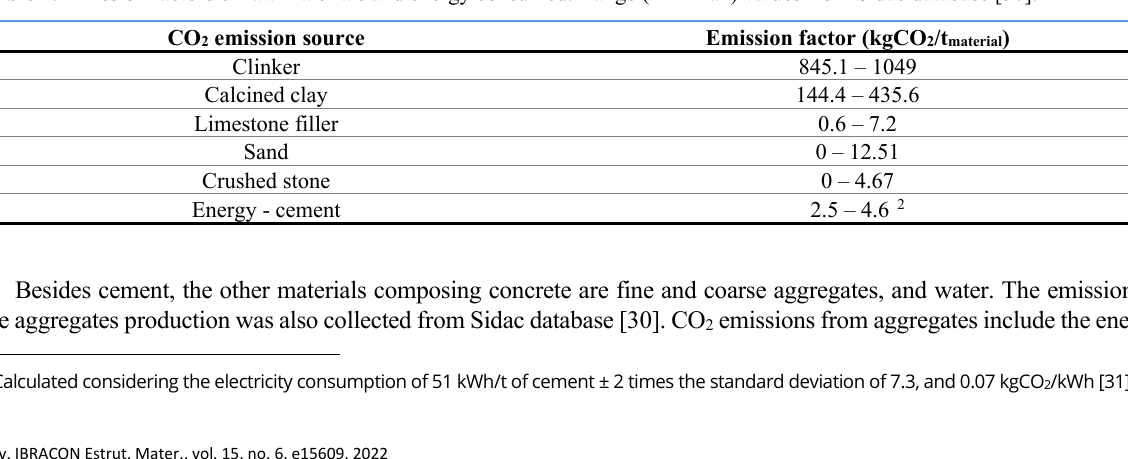
Table 2. Emission factors of raw materials and energy consumed. Range (min-max) values from Sidac database